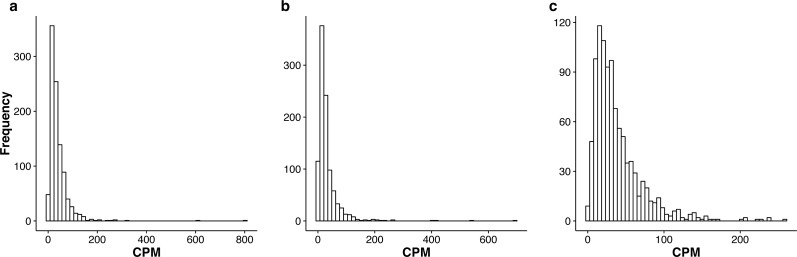
Histograms of the mean CPM (see Eq. (9)) for the top 1,000 most stably expressed genes identified from the seedling (A), leaf (B) and multi-tissue (C) groups using the total variance measure \documentclass[12pt]{minimal}
\usepackage{amsmath}
\usepackage{wasysym} 
\usepackage{amsfonts} 
\usepackage{amssymb} 
\usepackage{amsbsy}
\usepackage{upgreek}
\usepackage{mathrsfs}
\setlength{\oddsidemargin}{-69pt}
\begin{document}
}{}${\hat {\sigma }}^{2}$\end{document}σ ˆ2.The mean CPM is computed over all samples within each respective group. Note that the x and y axis scales differ between the three plots.